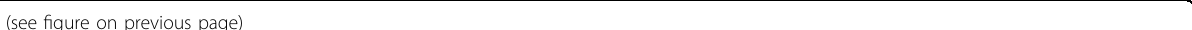
Fig. 1 Sca1 + endothelial cells expand preferentially after injuries. a Schematic fi gure showing genetic lineage tracing of Sca1 + cells. b Schematic fi gure showing experimental design. c Immunostaining for GFP, VE-Cad, SM22, or PECAM on heart sections. d Quanti fi cation of the percentage of VE-Cad + or PECAM + endothelial cells (ECs) expressing GFP. e Flow cytometric analysis of CD31 + ECs expressing GFP. f Schematic diagram showing experimental design for homeostasis study. g Immunostaining for GFP, VE-Cad, SM22, or PECAM on heart sections. h Quanti fi cation of the percentage of VE-Cad + or PECAM + ECs expressing GFP. i Flow cytometric analysis and quanti fi cation of the percentage of CD31 + cells expressing GFP. j Immunostaining for EdU, GFP, and VE-Cad on heart sections. Quanti fi cation of the percentage of EdU + cells in GFP + or GFP – populations. k Schematic diagram showing experimental design for TAC study. l Sirius red staining on sections from sham and TAC hearts. m Immunostaining for GFP, VE-Cad, SM22, or PECAM on heart sections, and the quanti fi cation of the percentage of VE-Cad + or PECAM + ECs expressing GFP. n Flow cytometric analysis and quanti fi cation of the percentage CD31 + ECs expressing GFP. o Immunostaining for EdU, GFP, and VE-Cad on TAC heart sections. Quanti fi cation of the percentage of GFP – or GFP + ECs incorporating EdU. p Immunostaining for TUNEL, GFP and VE-Cad on TAC heart sections. Quanti fi cation of the percentage of GFP – or GFP + ECs that are TUNEL + . q Schematic diagram showing experimental design for wire-induced injury. r HE staining on artery sections from sham or wire injury groups. s Immunostaining for GFP and VE-Cad on sections. Quanti fi cation of the percentage of ECs expressing GFP. t Flow cytometric analysis and quanti fi cation of the percentage of CD31 + ECs expressing GFP. u Immunostaining for EdU, GFP, and VE-Cad on injury arteries. Quanti fi cation of the percentage of GFP – or GFP + ECs incorporating EdU. v Immunostaining for TUNEL, GFP, and VE-Cad on injury arteries. Quanti fi cation of the percentage of GFP – or GFP + ECs that are TUNEL + . w Cartoon image showing preferential expansion of Sca1 + ECs after TAC or wire induced artery injuries. Scale bars, 100µm. Data are means ± SEM; n = 5; * P <0.05; ns, non-signi fi cant. Each fi gure is representative of 5 individual biological